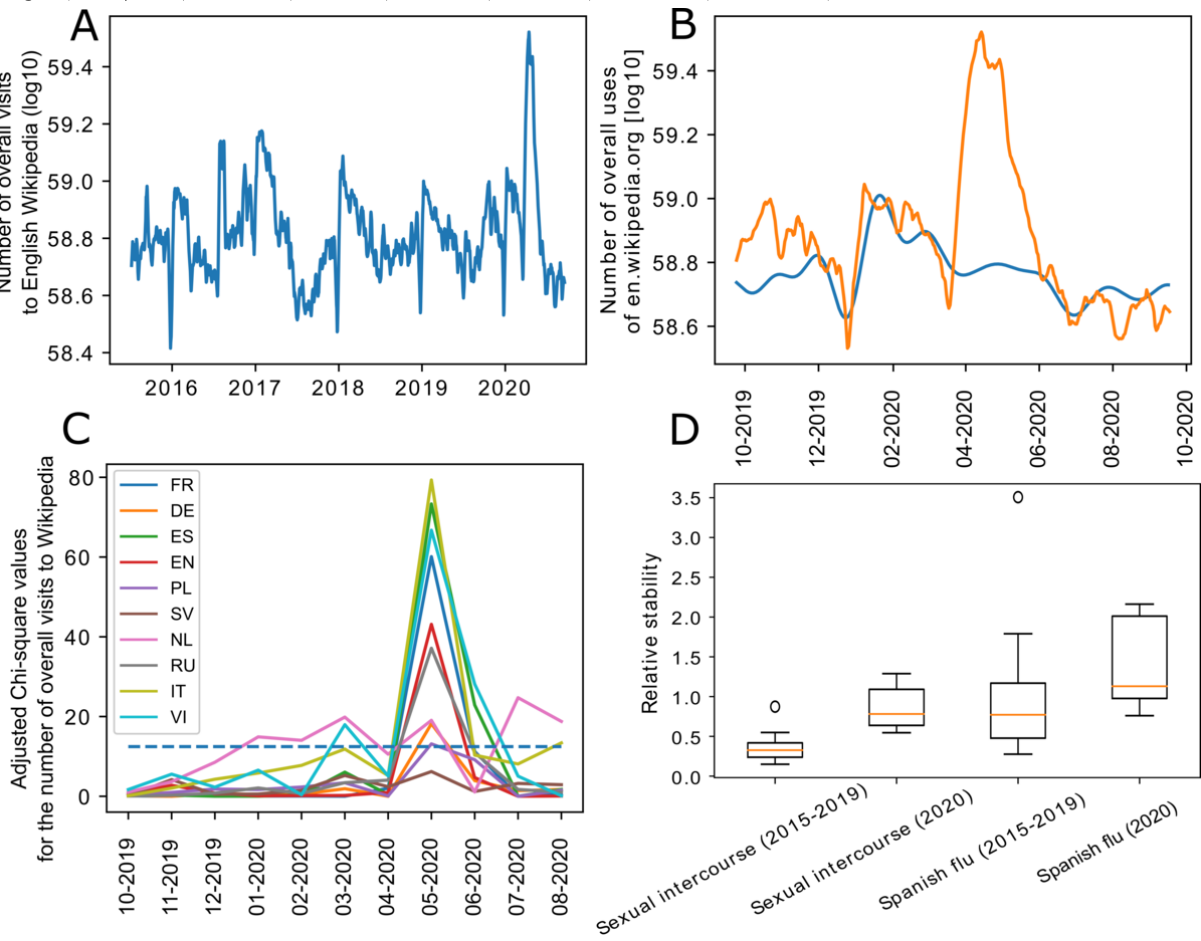
Figure 1. The disruption in annual Wikipedia visit patterns. (A) The pattern of general English Wikipedia access from 2015 to 2020 (Multimedia Appendix 3). Data for other language versions of Wikipedia are provided in Multimedia Appendix 4, Supplementary Figures S1a-S9a. (B) The FBProphet prediction model was created based on data from the 2015-2019 period. The model compared expected behaviors in 2020 (ie, the blue line) to observed access (ie, the orange line). Data for the other language versions of Wikipedia are provided in Multimedia Appendix 4, Supplementary Figures S1b-S9b. (C) A summary of monthly general access to Wikipedia across all Wikipedia language versions from September 2019 to September 2020. Solid lines represent Chi-square goodness-of-fit values and the dashed line represents the cutoff value. (D) The stability of the two reference Wikipedia articles across all languages in the 2015-2019 and 2020 periods (ie, the moving SD divided by mean percent access across a 30-day window). DE: German; EN: English; ES: Spanish; FR: French; IT: Italian; NL: Dutch; PL: Polish; RU: Russian; SV: Swedish; VI: